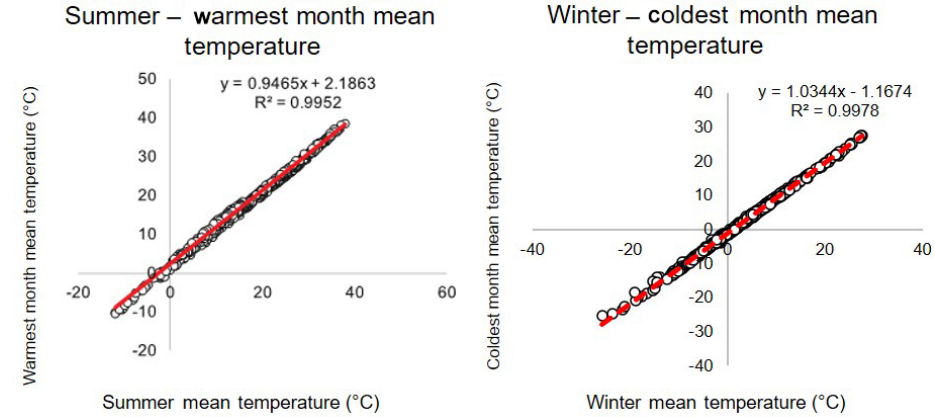
Figure A1. Correlation between summer and warmest month mean temperature as well as winter and coldest month mean temperature (Reichgelt et al., 2018). This correlation was used to compare bioclimatic analysis results to CLAMP results, as the former uses the summer and winter mean, and the latter uses warmest and coldest month means.